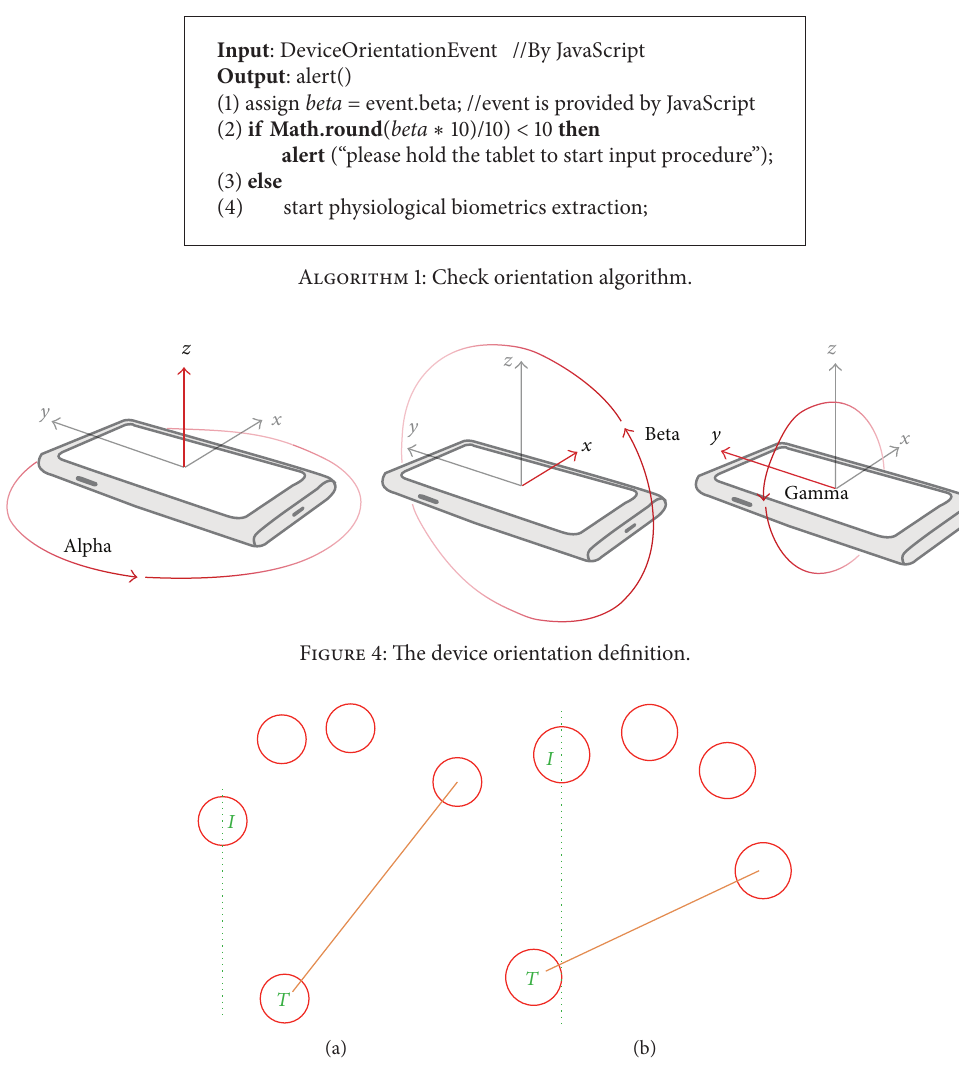
Figure 5: (a) Natural pose with the fingers in order, (b) natural pose with different thumb position, and natural pose with left-handed side user.